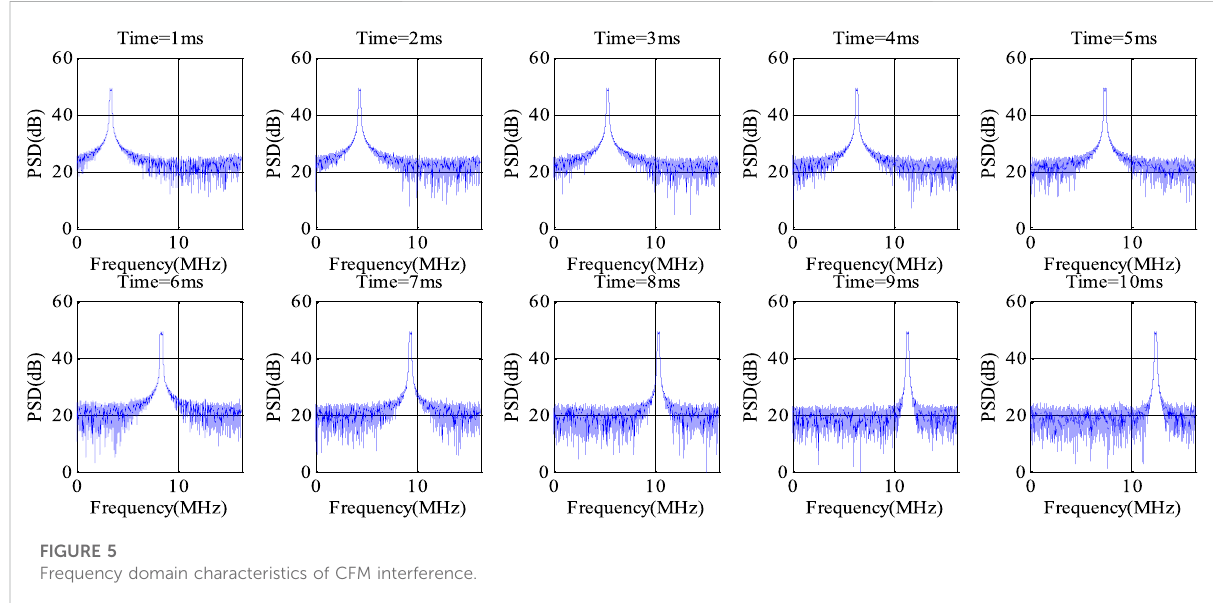
FIGURE 5 Frequency domain characteristics of CFM interference.